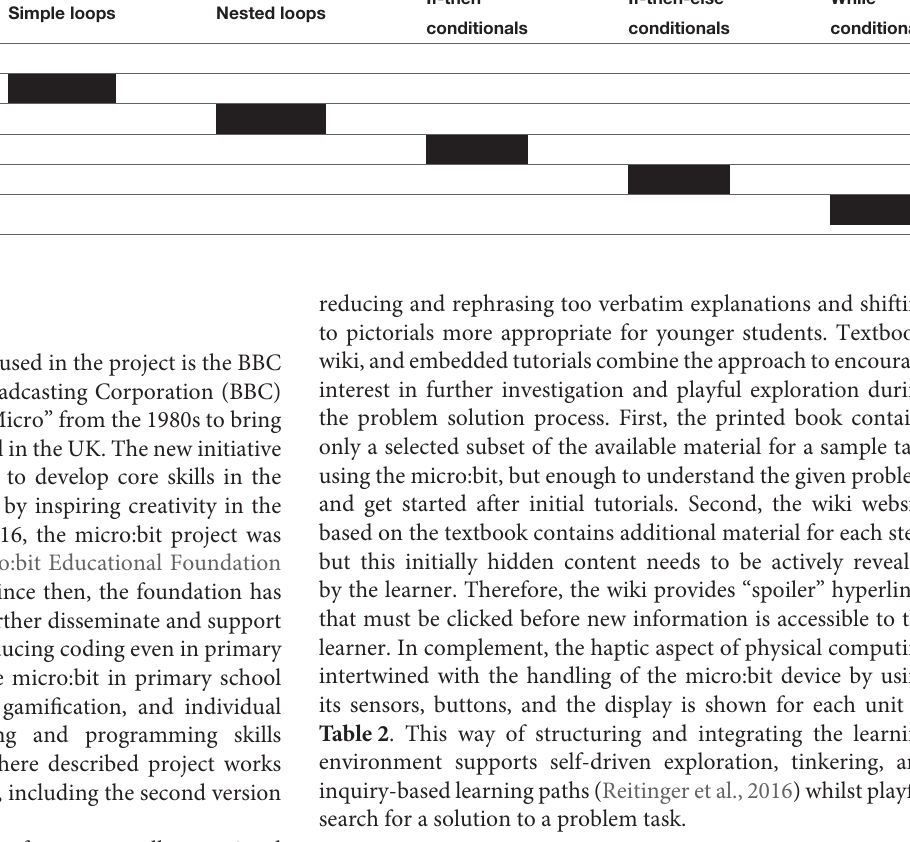
TABLE 1 | Computational concepts in BCTt (Zapata-Cáceres et al., 2021).